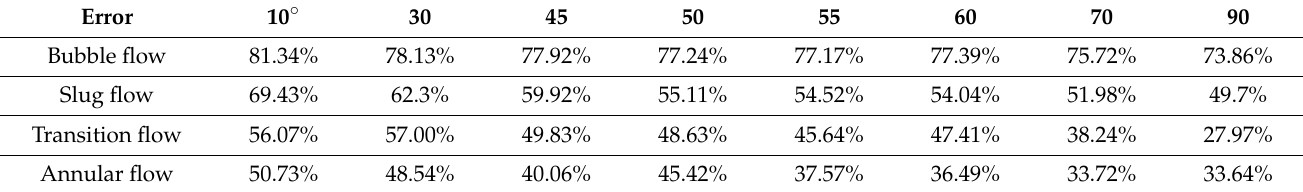
Table 4. The calculation error for the B–B model applied to the atmospheric liquid